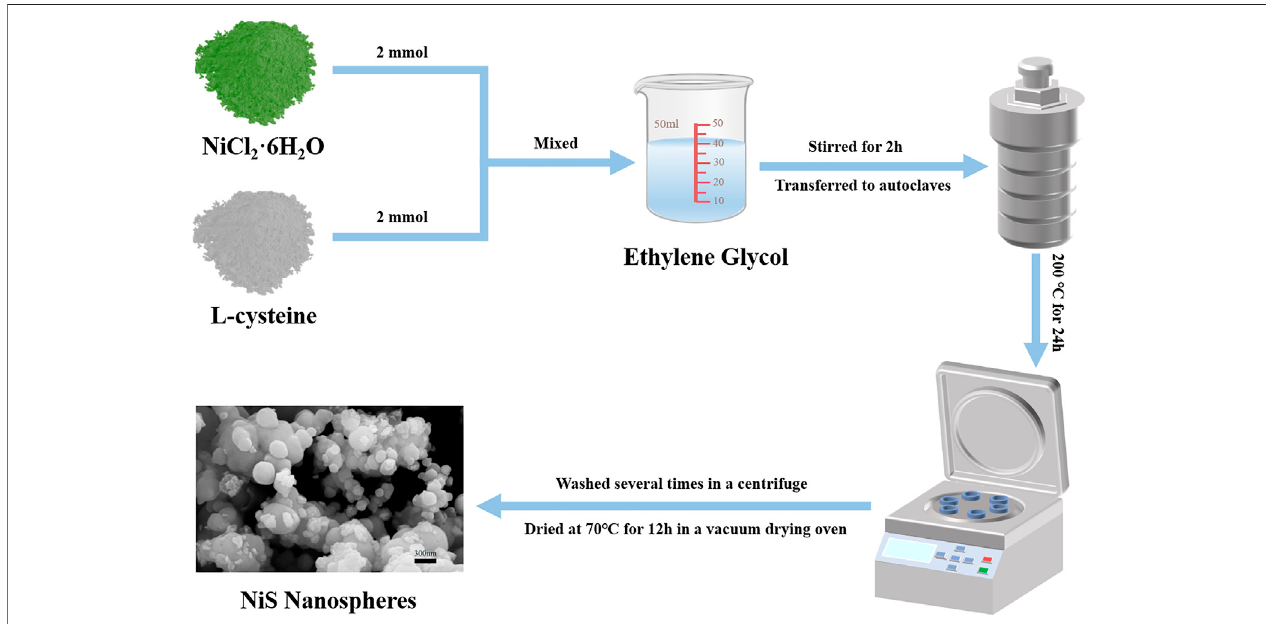
FIGURE 1 | The schematic diagram of preparing NiS